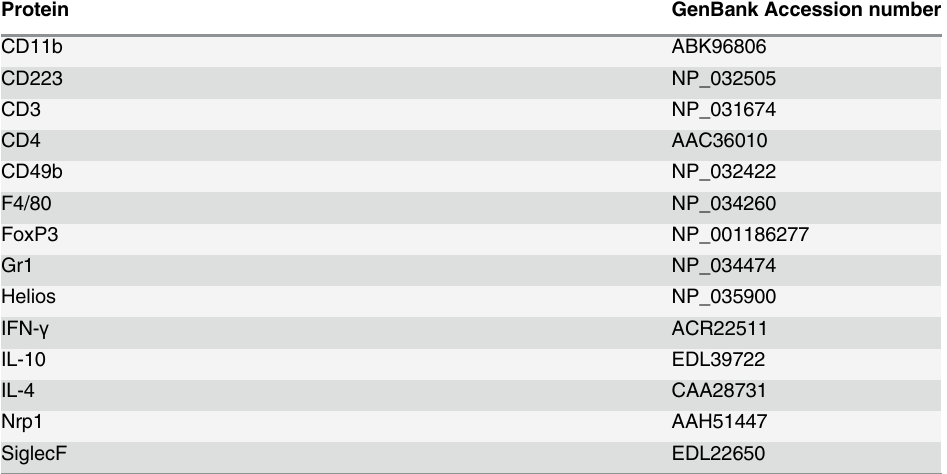
S1 Fig. Gating strategy for Dermal Exudate Cells. ( A ) Representative flow cytometry dot